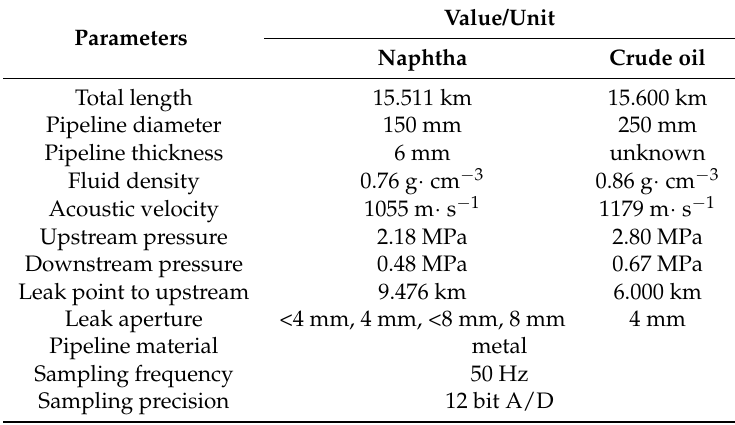
Table 2. Parameters of the naphtha and crude oil